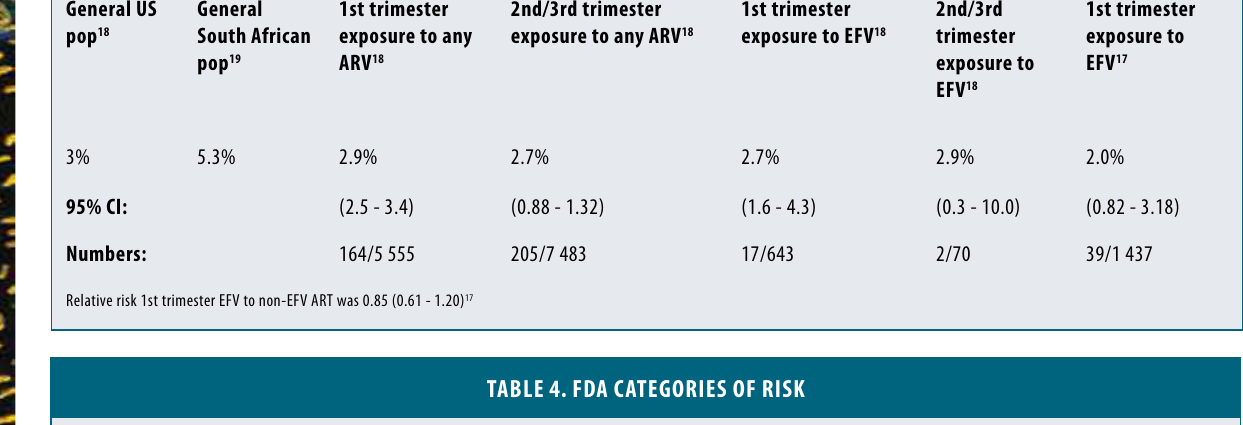
taBle 4. fD a categorIes of rIsk